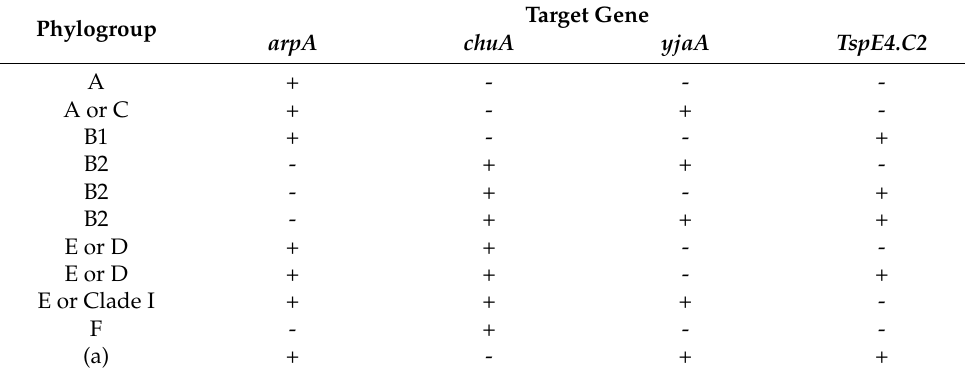
Table 8. Assignment of phylogroups of E. coli isolates based on the presence of genes arpA , chuA , yjaA , and TspE4.C2